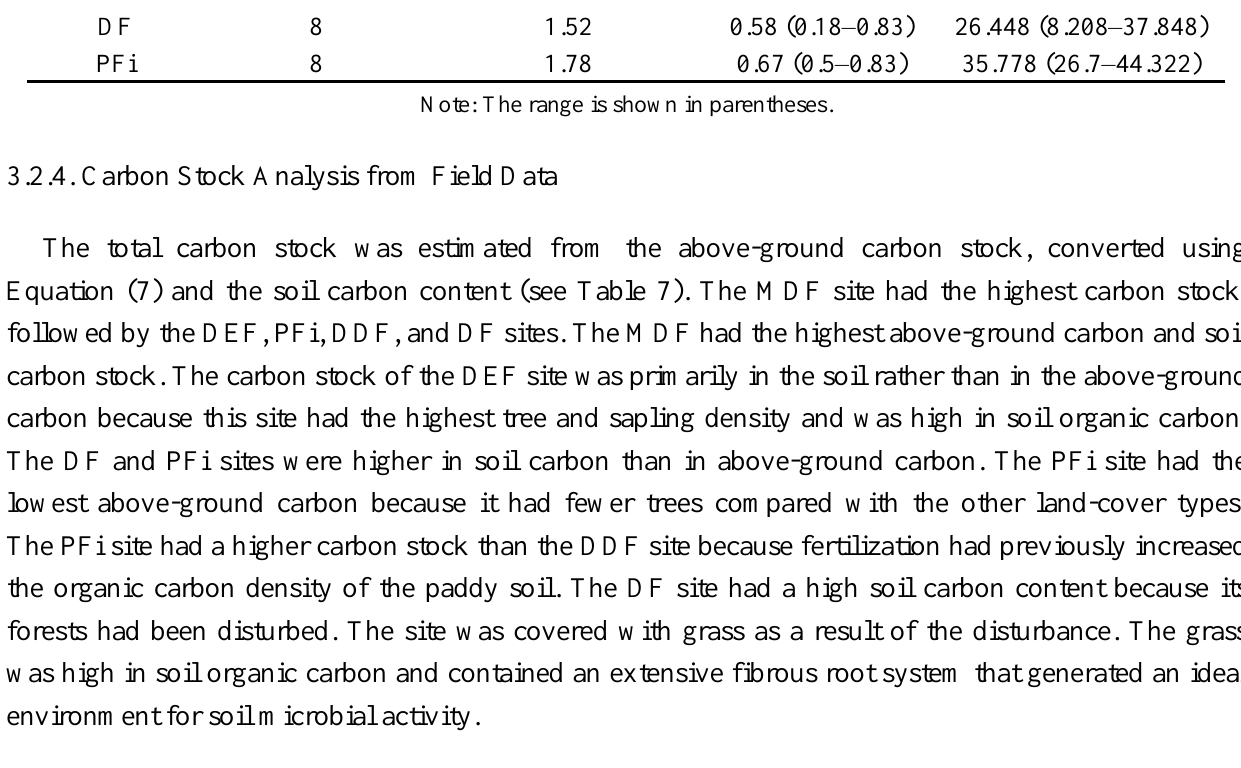
Table 7. Average total carbon stock by land-cover